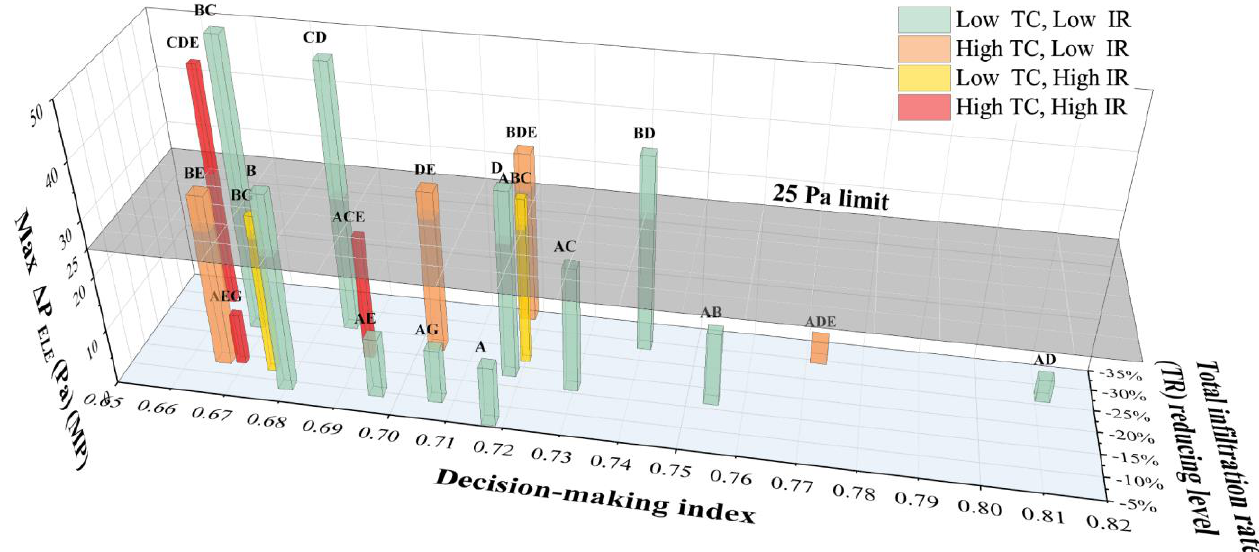
Figure 16. The multilateral comparison of decision-making.